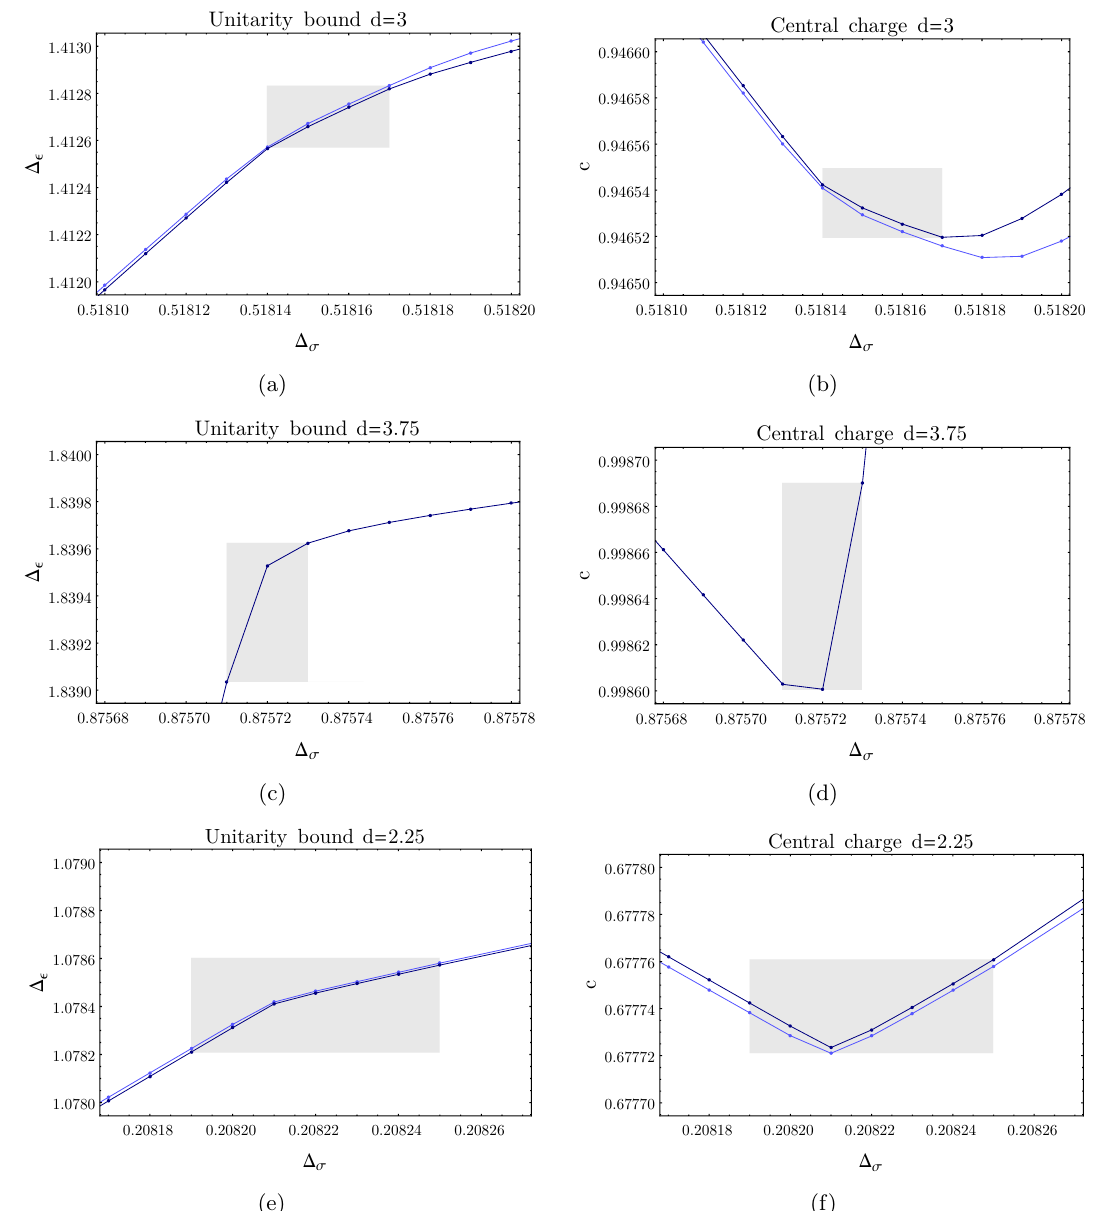
Figure 2 . Determination of the Ising critical point for d = 3 (rescaled view of (cid:12)gure 1), d = 3 : 75 and d = 2 : 25. As in (cid:12)gure 1, the light (dark) blue lines correspond to bootstrap equations with 153 (190) components and the grey area is the